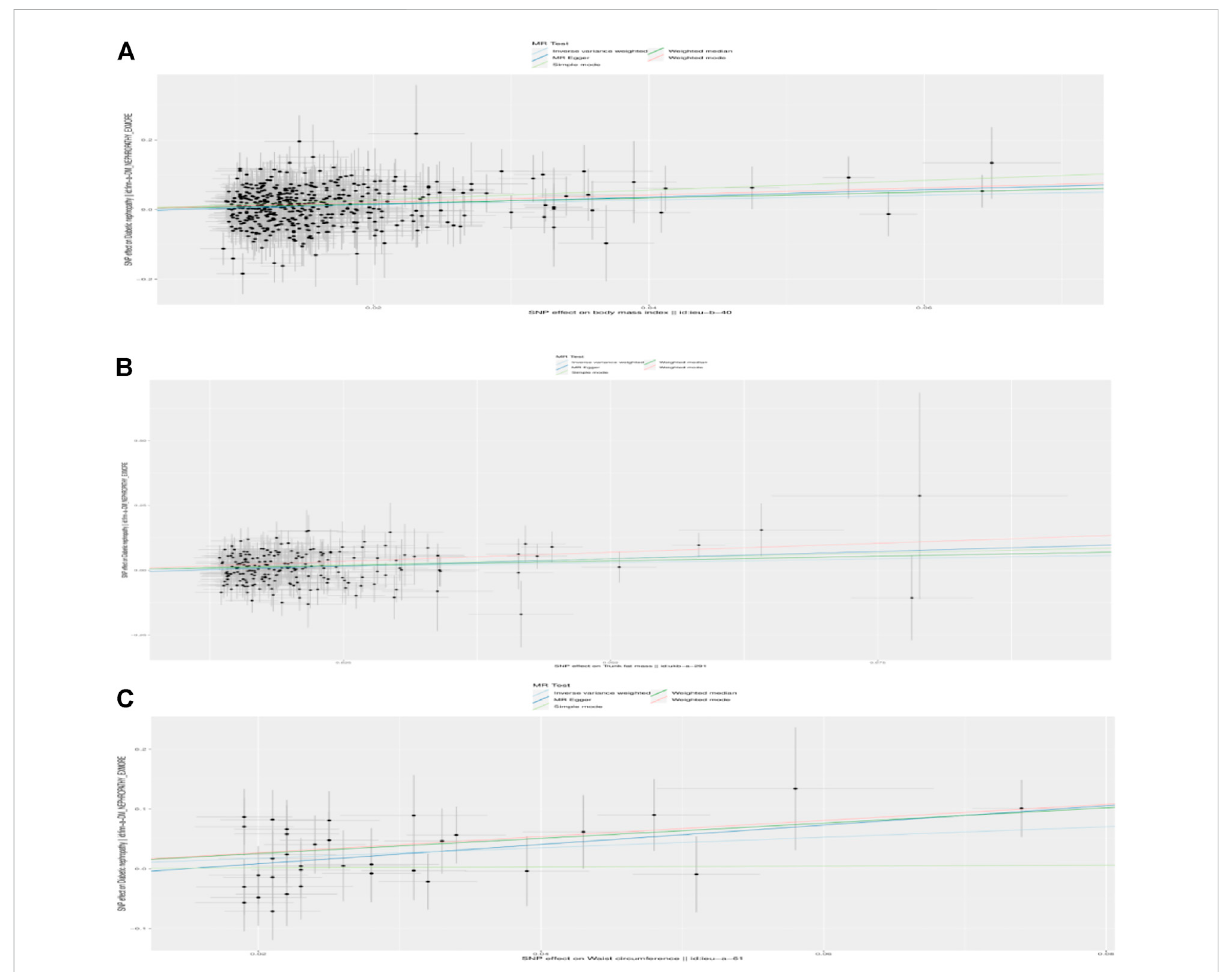
Scatterplot to visualize causal effect of the body mass index (BMI), trunk fat mass, and WC on DKD. (A) Causal effect of BMI on DKD. (B) Causal effectoftrunkfatmassonDKD. (C) CausaleffectofWConDKD.Theslopeofthestraightlineindicatesthemagnitudeofthecausalassociation.IVW, inverse-variance weighted; MR, Mendelian